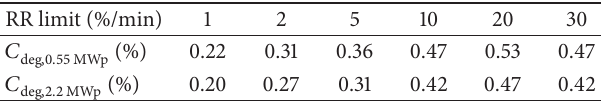
Table 2: Cycling induced degradation of an Altairnano battery energy storage system compensating the power fluctuations of two different PV generators with different ramp rate limits located in Northern European climate during the year 2012.